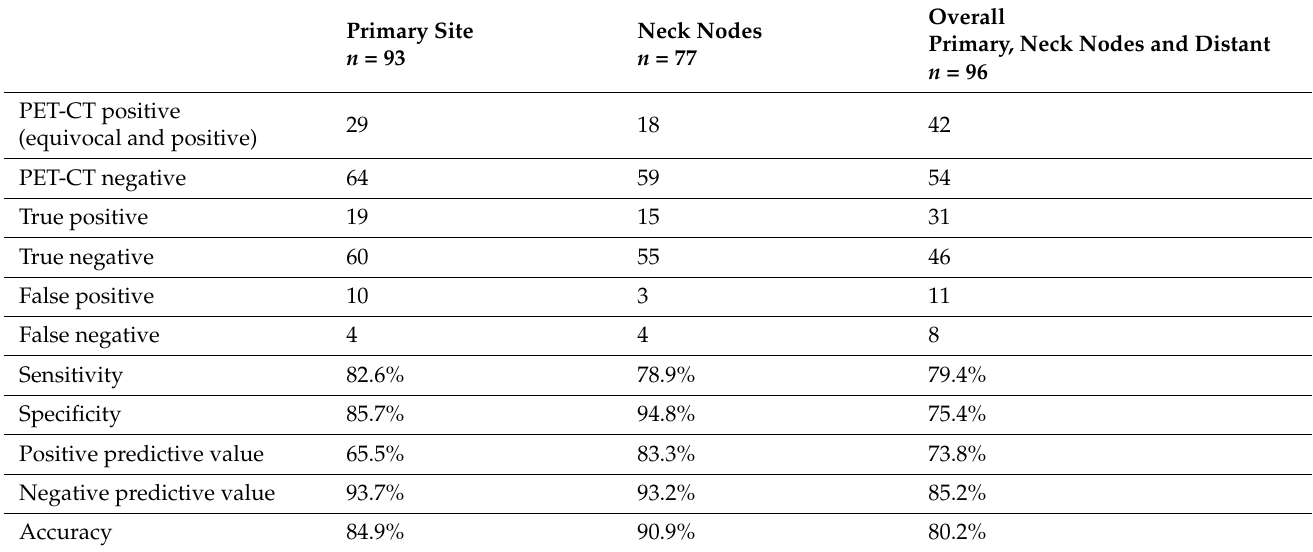
Table 2. Details of accuracy of PET-CT response scans comparing complete metabolic response versus